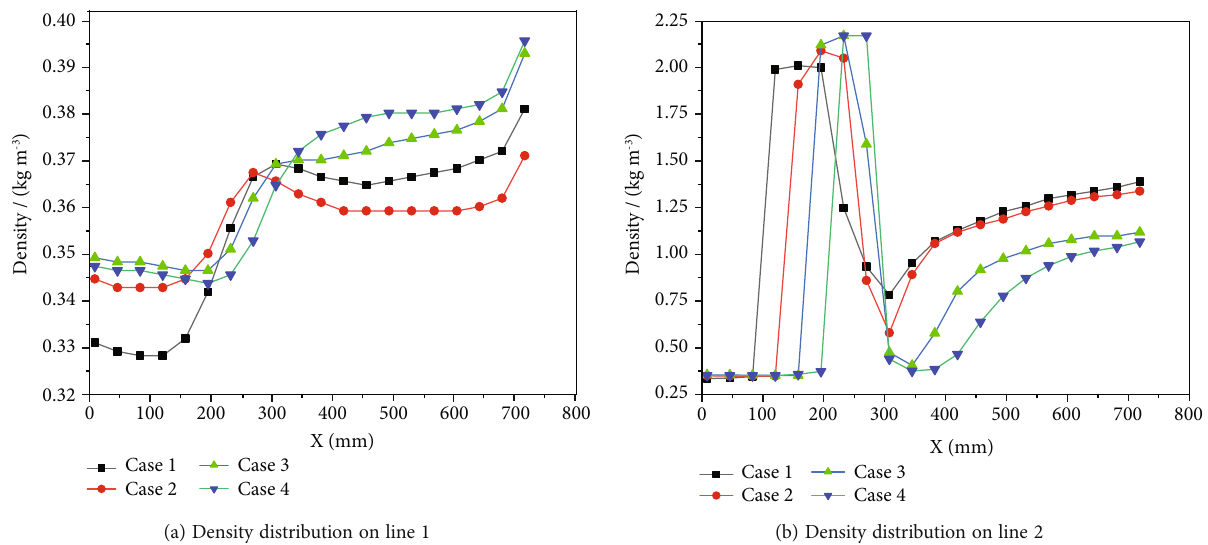
Figure 19: Density distribution on two marking